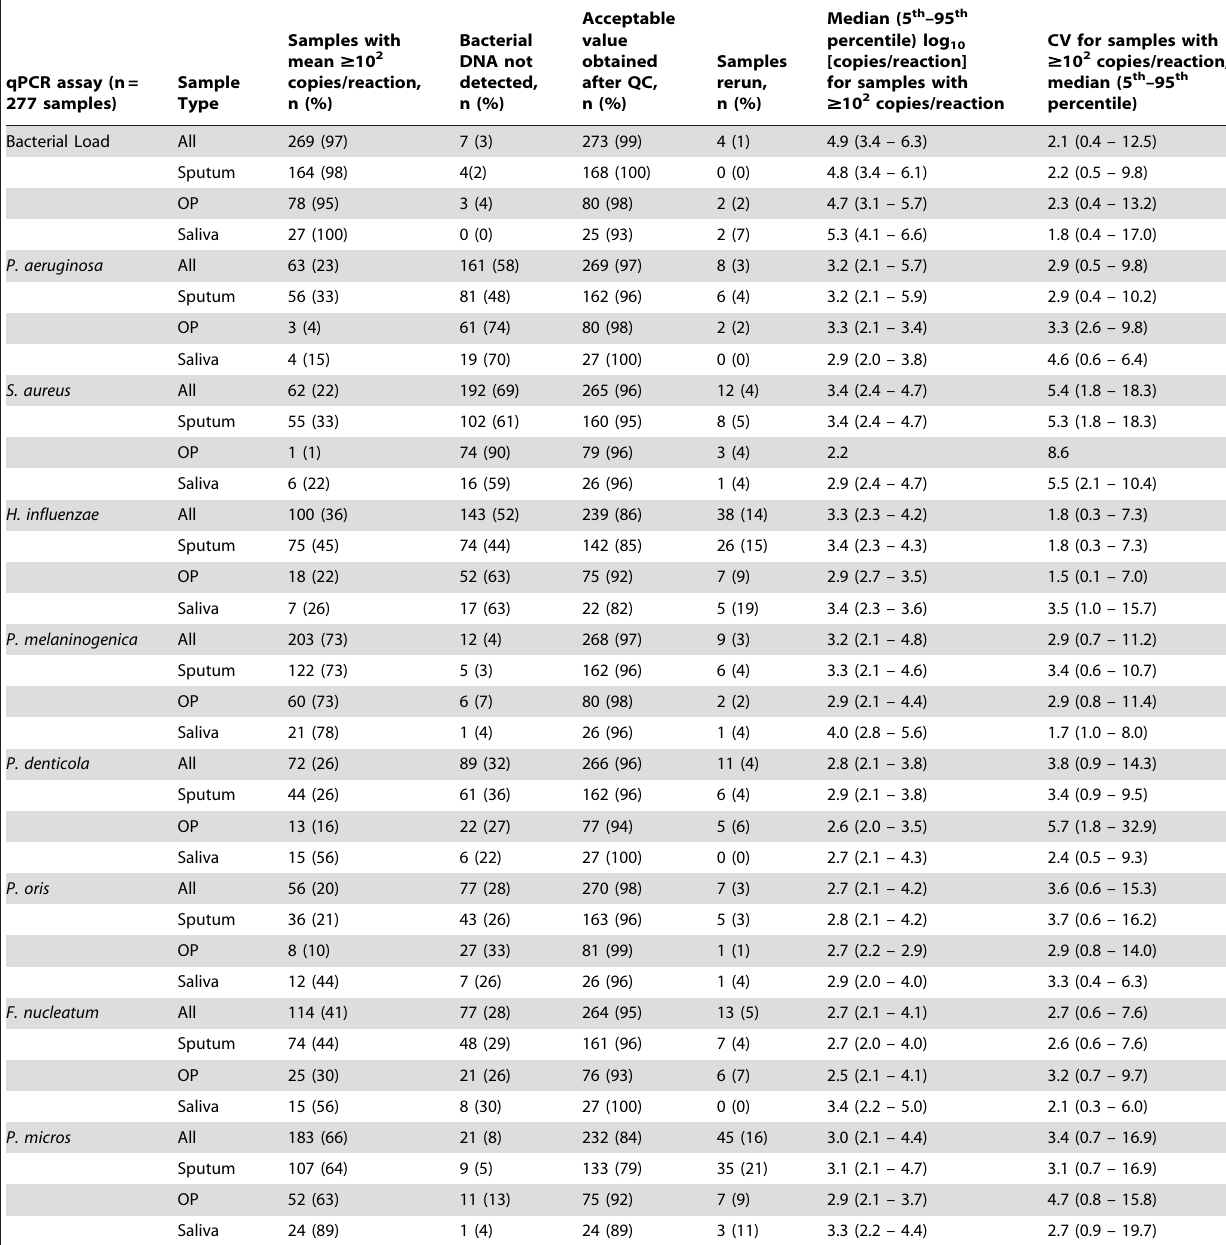
Table 2. Results from quantitative PCR